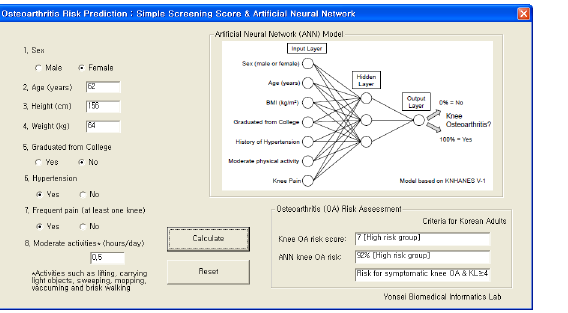
Fig 5. A screen image of the osteoarthritis risk calculator based on artificial neural network. This software is available at https://sites.google.com/site/taekeunyoo/oa-risk-calculator.